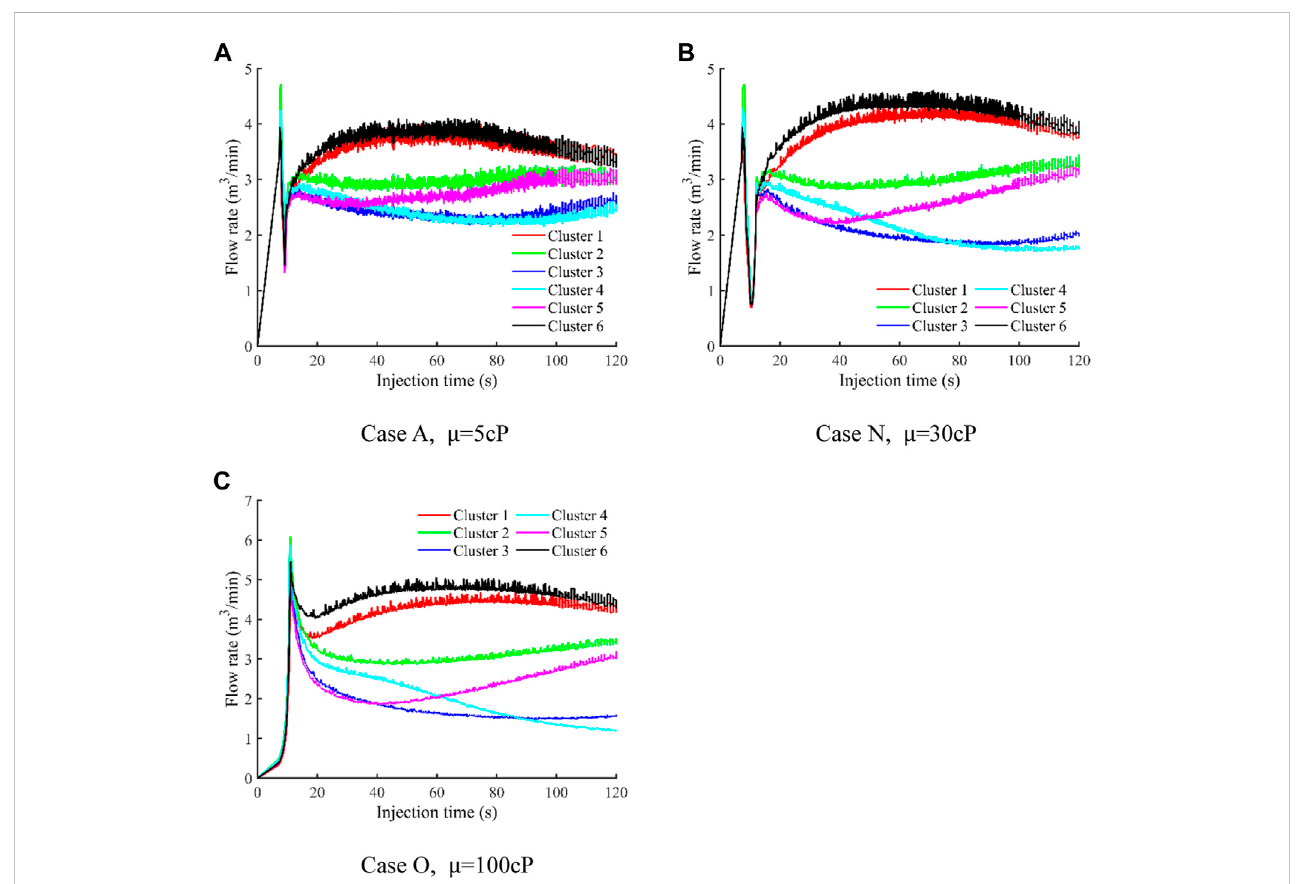
FIGURE 19 Flowrateintoeachclusterasafunctionoftimeforthreecaseswithdifferentfracturing fl uidviscosity. (A) CaseA, μ =5 cP. (B) CaseN, μ =30 cP. (C) Case O, μ = 100 cP.